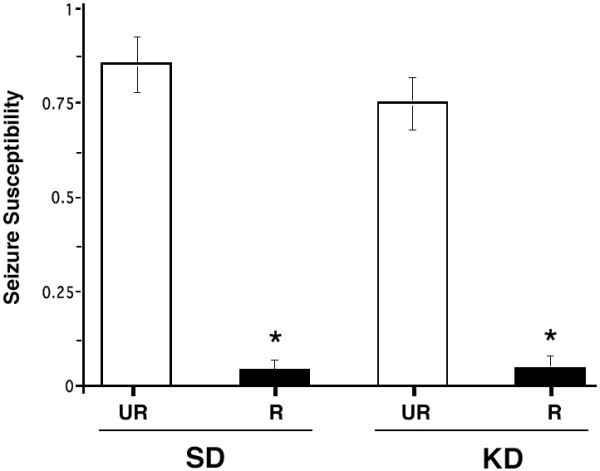
Influence of diet on seizure susceptibility in adult EL mice. Asterisks indicate that seizure susceptibility was significantly lower (p < 0.001) in the R-fed groups than in their respective UR-fed groups. Values were pooled from treatment weeks 5–12 (see Fig. 1) and are expressed as the mean ± SEM (n = 6 mice per group).